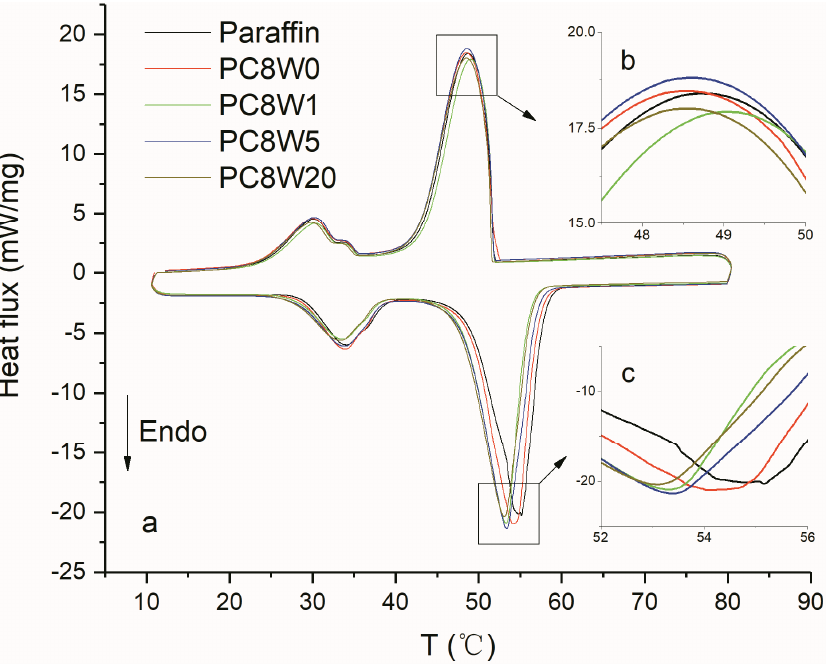
Figure 10. DSC curves of different AGA/paraffin composites ( a ); ( b ) and ( c ) are the amplification view of the exothermic peaks and endothermic peaks, respectively.